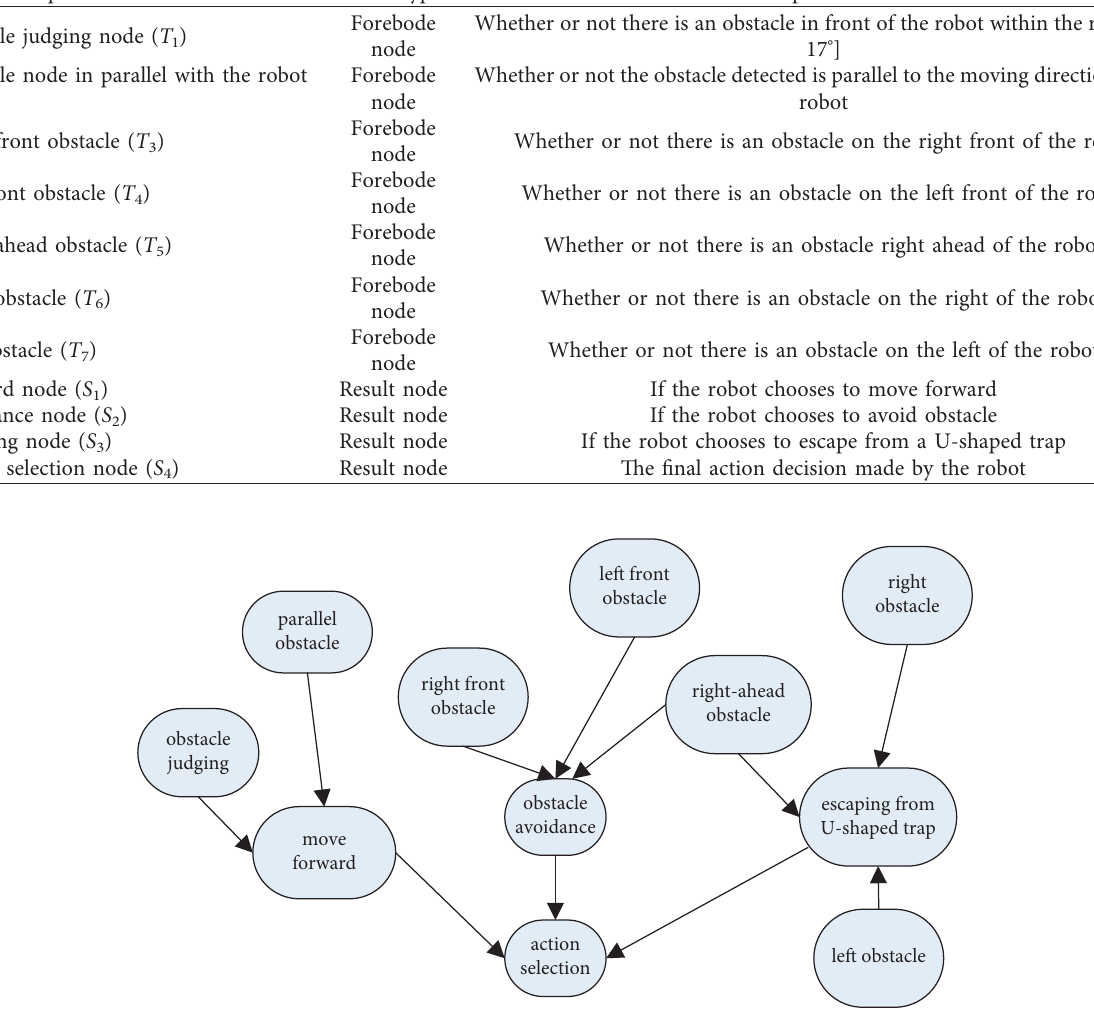
Figure 5: Bayesian network model. 2